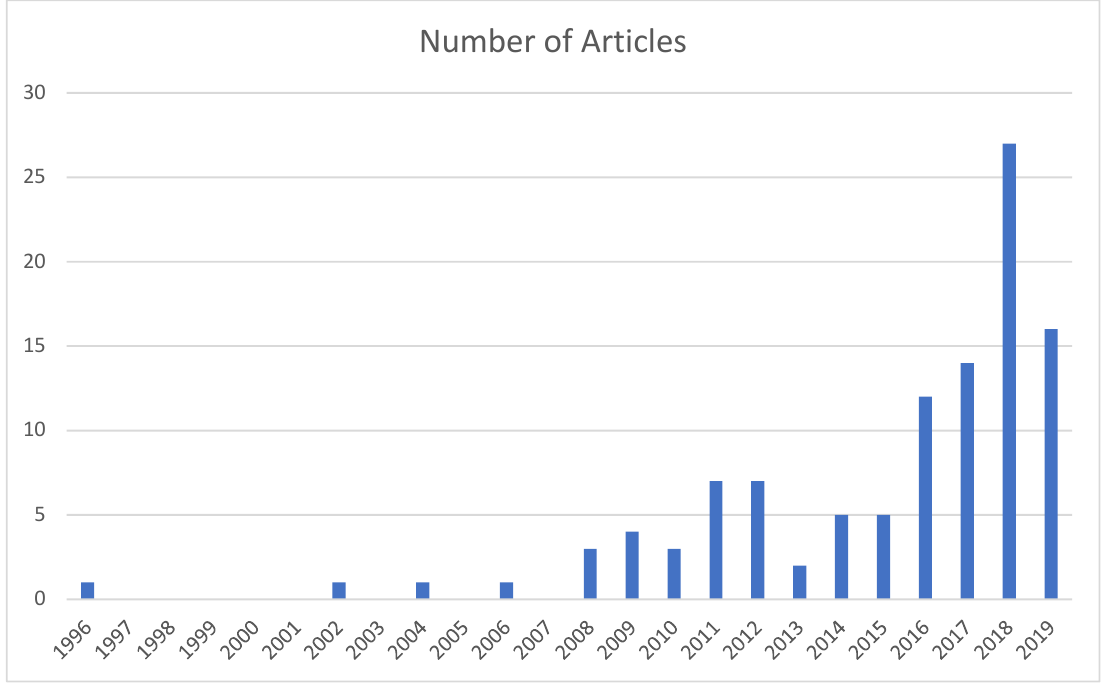
Figure 2. Number of publications over the years.